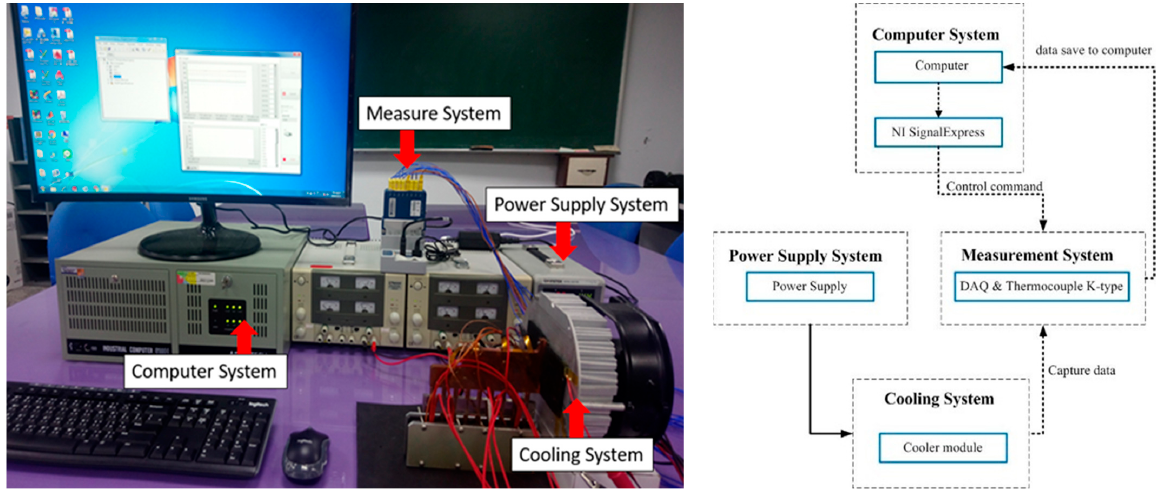
Figure 12. A schematic of system planning for the active heat dissipation device. Table 3. Specifications of the hardware.